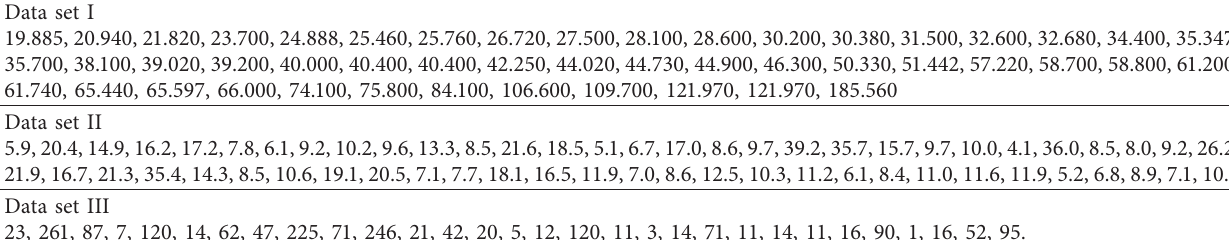
Table 9: Maximum annual flood discharges, actual taxes, and failure times of the air-conditioning data